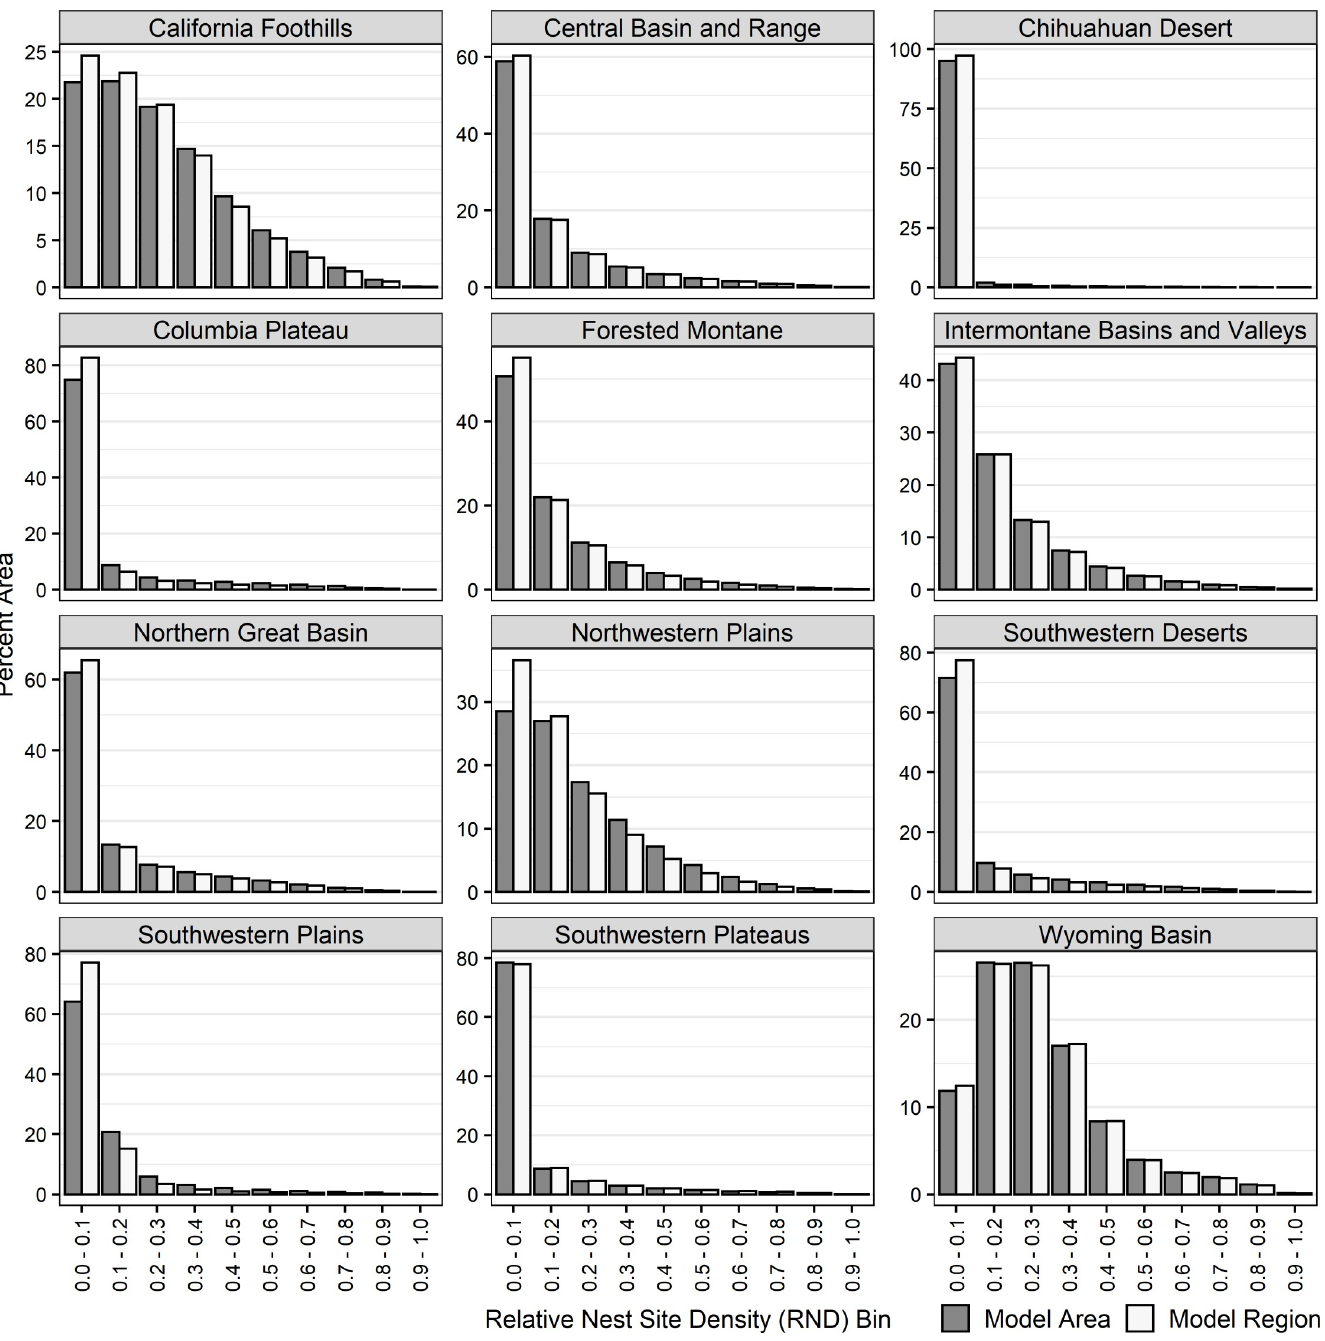
Fig 6. Percent area within ten equal-sized relative nest site density (RND) bins in modeling areas (gray bars) and modeling regions (white